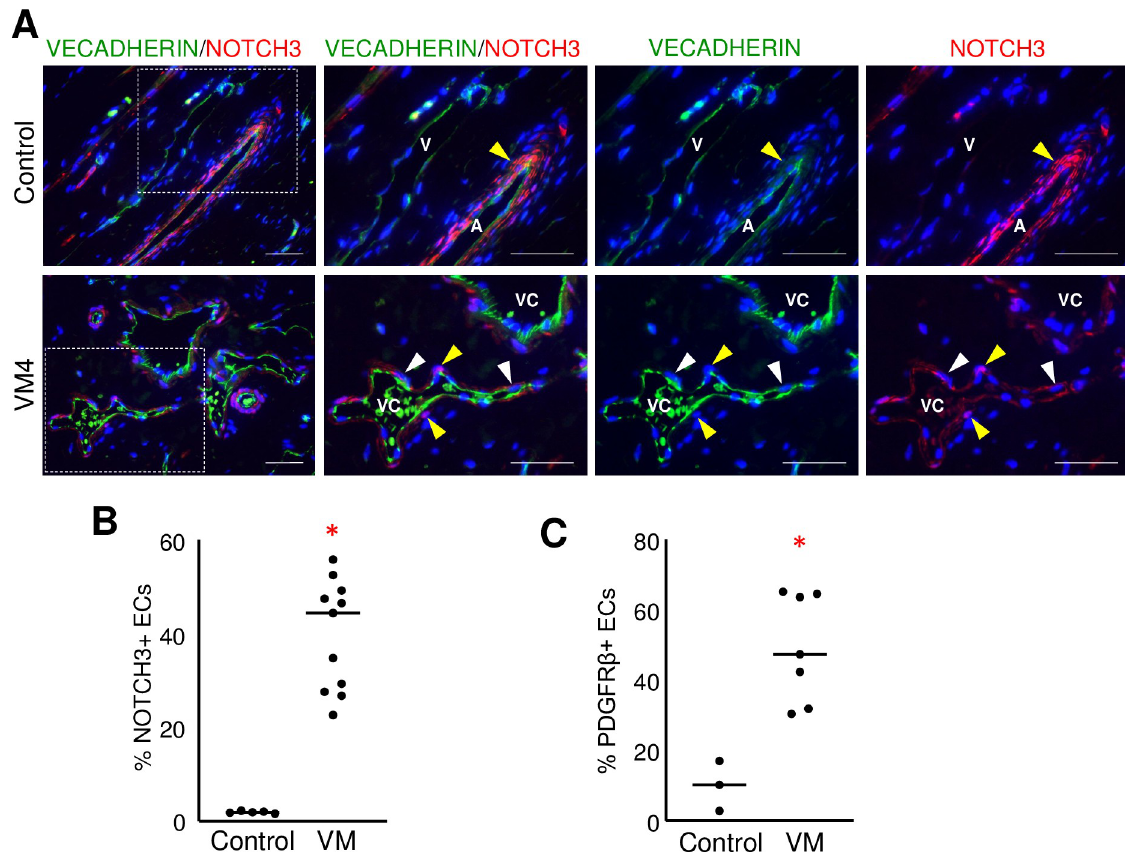
Fig 5. NOTCH3 and PDGFR β were expressed in the endothelium of VMs. (A) Representative images of VMs and control neonatal dermis co-stained for VECADHERIN and NOTCH3. Yellow arrowheads mark VECADHERIN-/NOTCH3+ mural cells, and white arrowheads mark VECADHERIN+/NOTCH3+ ECs. Boxed areas are enlarged to the right. A-artery, V-vein, VC-VM channel. Scale bars—50 μ m. (B) Quantification of percent NOTCH3+ ECs in VMs (n = 11) and controls (n = 5). Bar represents median value, � p < 0.0001. (C) Quantification of percent PDGFR β + ECs in VMs (n = 7) and controls (n = 3). Bar represents median value, � p < 0.005.